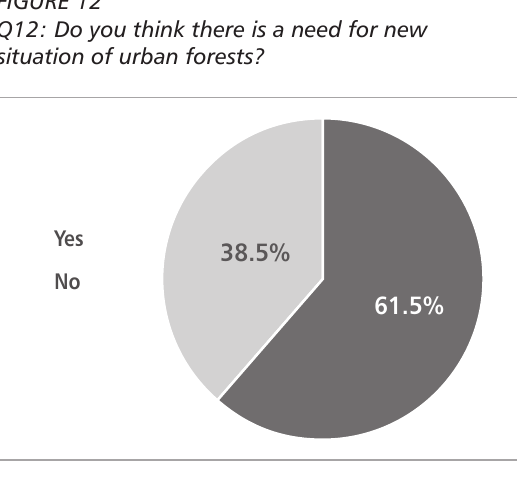
Q12: Do you think there is a need for new situation of urban